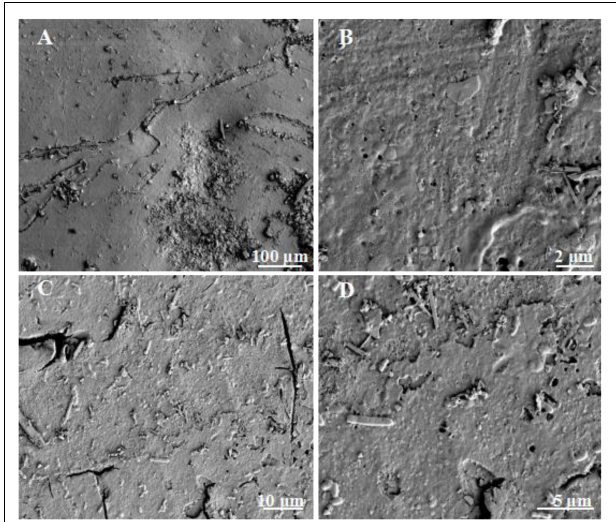
FIGURE 2 | Surface ultrastructure of bio-eroded snail shells. (A) The surface of the healthy snail shell; (B) the small voids on the surface of the healthy shell; (C) the surface of the bio-eroded snail shell, with relatively large cracks; (D) the surface of the bio-eroded snail shell, with some microorganisms attached, with some small gaps.